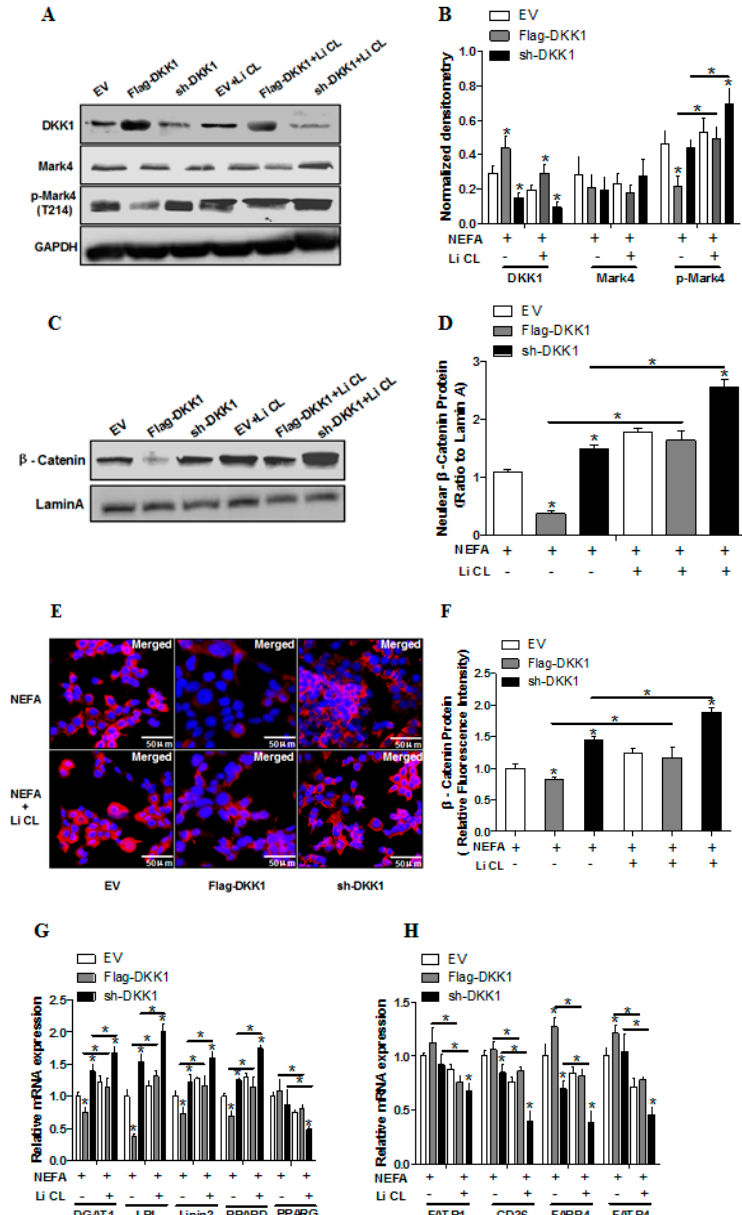
Figure 5. Inhibition of the Wnt/ β -catenin pathway blocks key molecules of lipid metabolism and activation of MARK4 in pig primary trophoblast cells. ( A – D ) Representative immunoblots and densitometric quantification for p-MARK4 (T214), DKK1 and β -catenin after transfection with Flag-DKK1, sh-DKK1 for 48 h in primary trophoblast cells isolated from pig placentas. Cells were then incubated with 400 µ M NEFA or 20 µ M Li CL for 24 h ( n = 3). ( E ) Representative images (100 × ) of β -catenin immunofluorescent staining after transfection with Flag-DKK1, sh-DKK1 for 48 h in pig primary trophoblast cells. Cells were then incubated with 400 µ M NEFA or 20 µ M Li CL for 24 h ( n = 3). ( F ) Quantification of red fluorescence intensity in ( E ) relative to control group ( n = 3). ( G – H ) Relative mRNA expression of lipid metabolism-related genes ( G ) and fatty acid (FA) transporters ( H ) after transfection with Flag-DKK1, sh-DKK1 for 48 h in primary trophoblast cells. Cells were then treated with 400 µ M NEFA or 20 µ M Li CL for 24 h ( n = 3). Values are expressed as mean ± SEM. * p < 0.05 compared with the control group. Flag-DKK1 group: overexpression of DKK1 group, sh-DKK1 group: knock down of DKK1 group, Control: empty vector (EV)